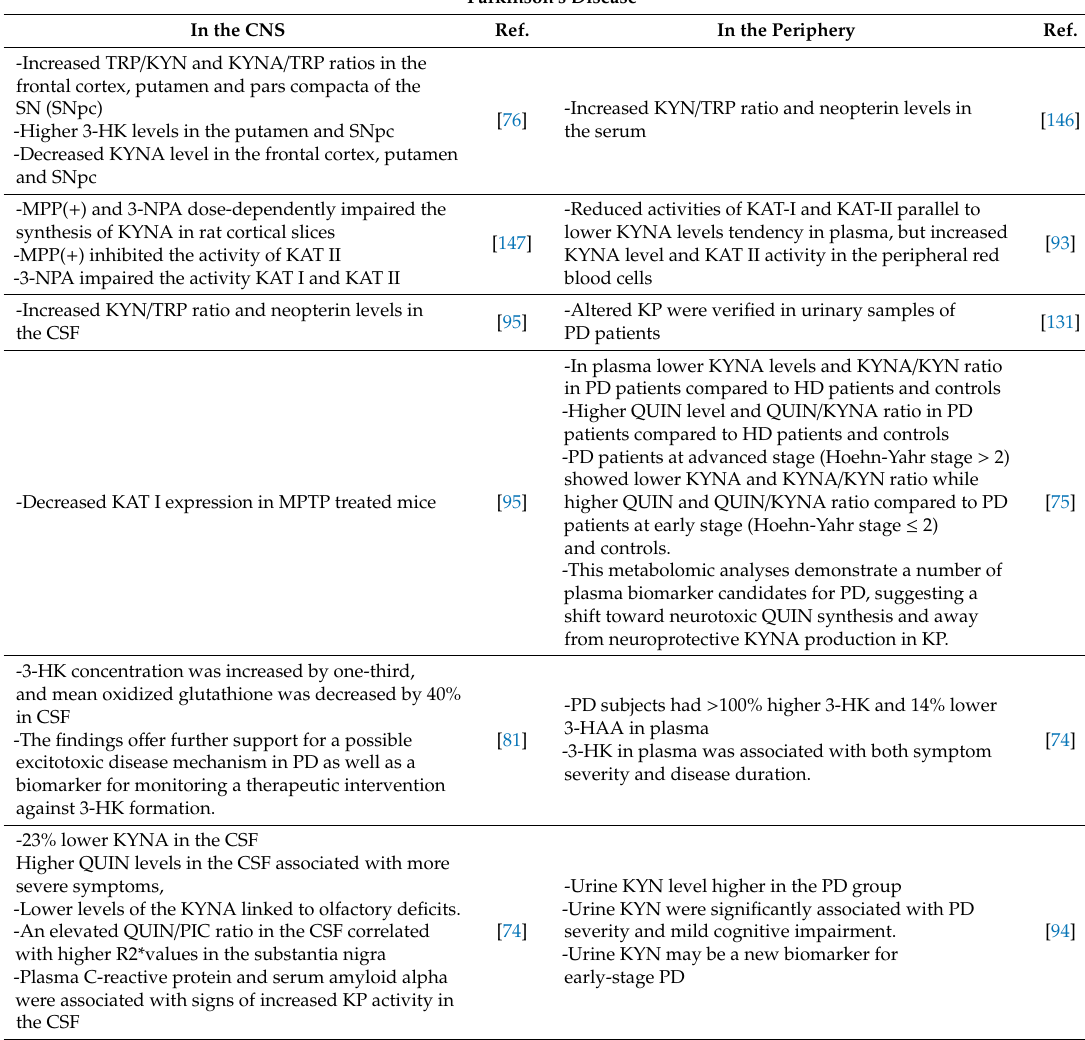
Table A2. Di ff erences of kynurenine pathways in the CNS and the periphery in Parkinson’s disease. Parkinson’s